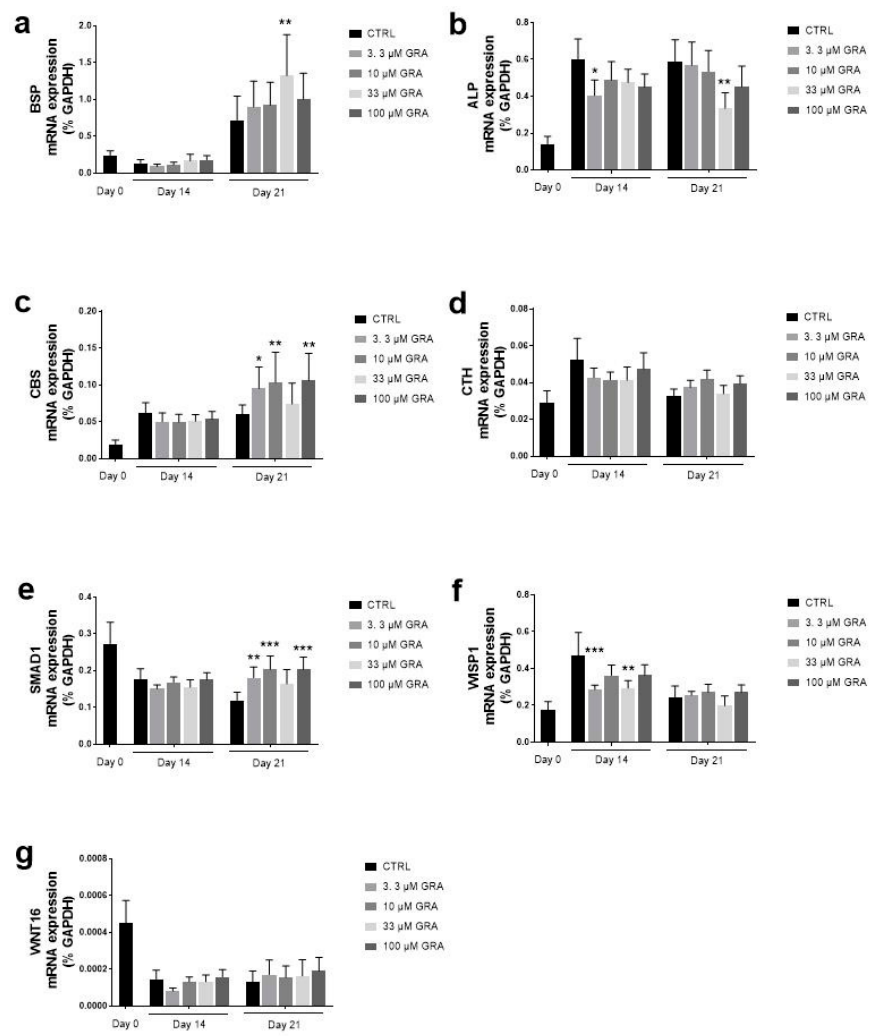
Figure 5. mRNA expression of osteogenic markers in hMSCs after stimulation with GRA. Histograms of mRNA expression of BSP ( a ), ALP ( b ), CBS ( c ), CTH ( d ), SMAD 1 ( e ), WISP-1 ( f ), WNT16 ( g ) at day 0, day 14, and day 21 and are expressed as mean ± SEM of six independent experiments. Two-way ANOVA with repeated measures by two factors (time and treatment) and Dunnett’s multiple comparison test vs. control cells at each time point were performed for statistical analysis (* p < 0.05, ** p < 0.01, *** p < 0.001 vs. control at day 14 or day 21).